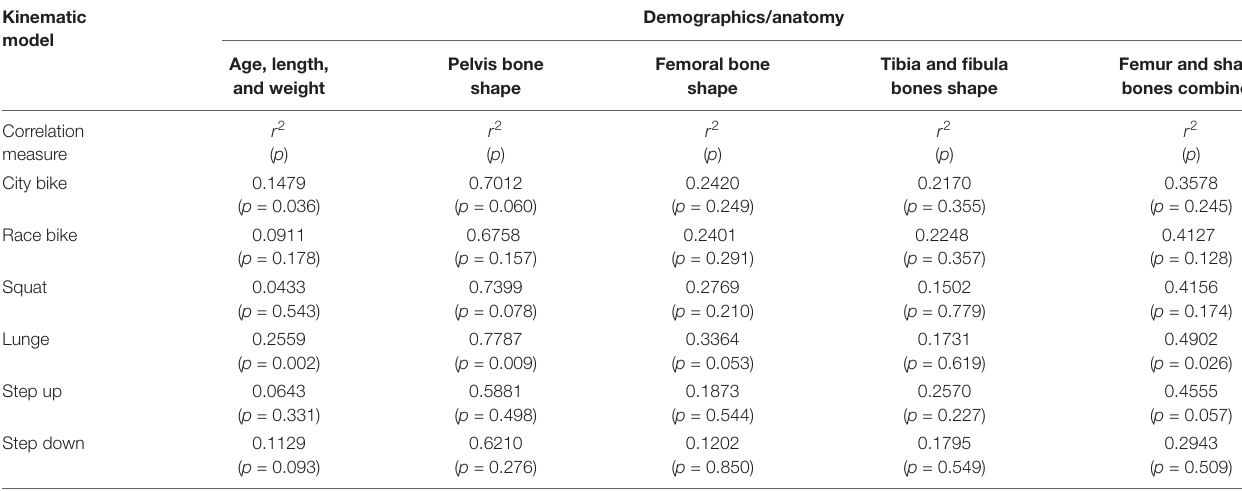
TABLE 3 | Canonical correlation analysis between the significant shape PC weights or biometric variables and the first kinematic mode. Kinematic model